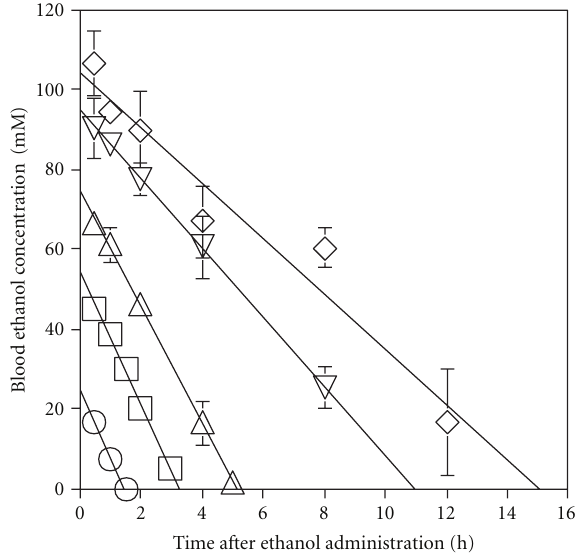
Figure 1: Time course of blood ethanol concentration in mice after ethanol administration (i.p.) at various doses. Each plot represents the mean ± SD of 3 mice. (cid:2) 1 g/kg; (cid:2) 2g/kg; (cid:3) 3g/kg; (cid:3) 4.5 g/kg; (cid:4)